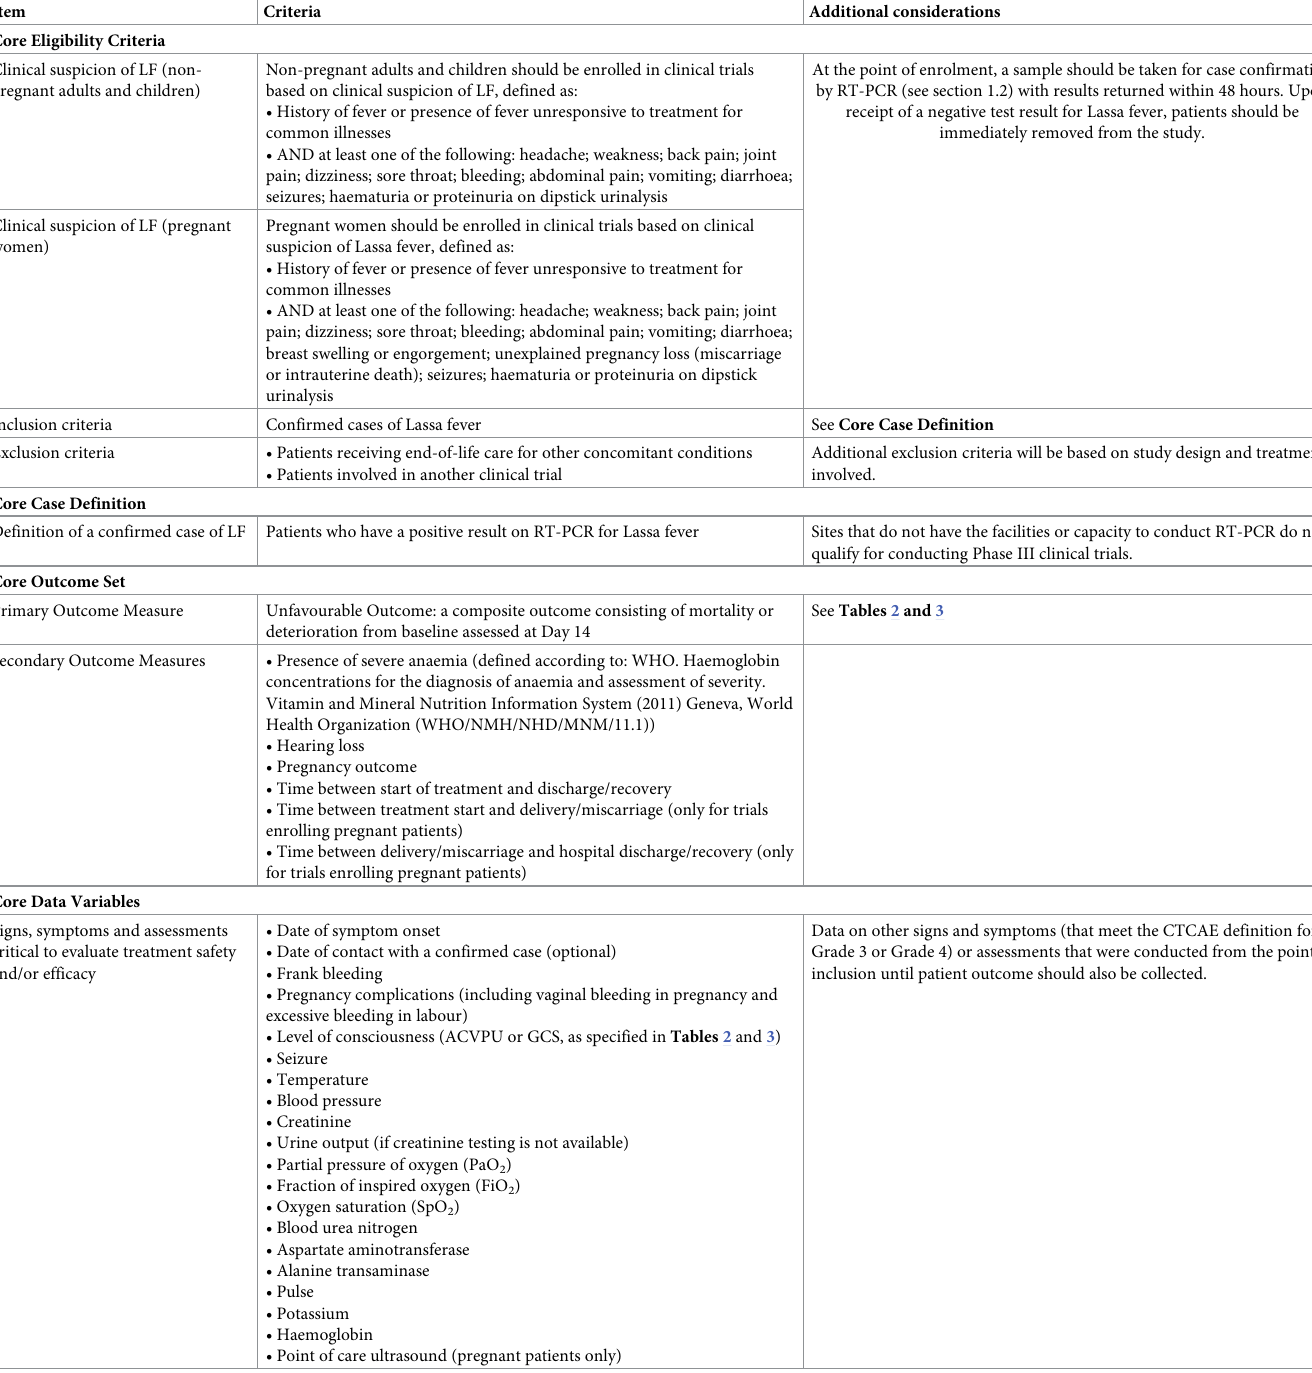
Table 1. Core outputs and definitions included in the final